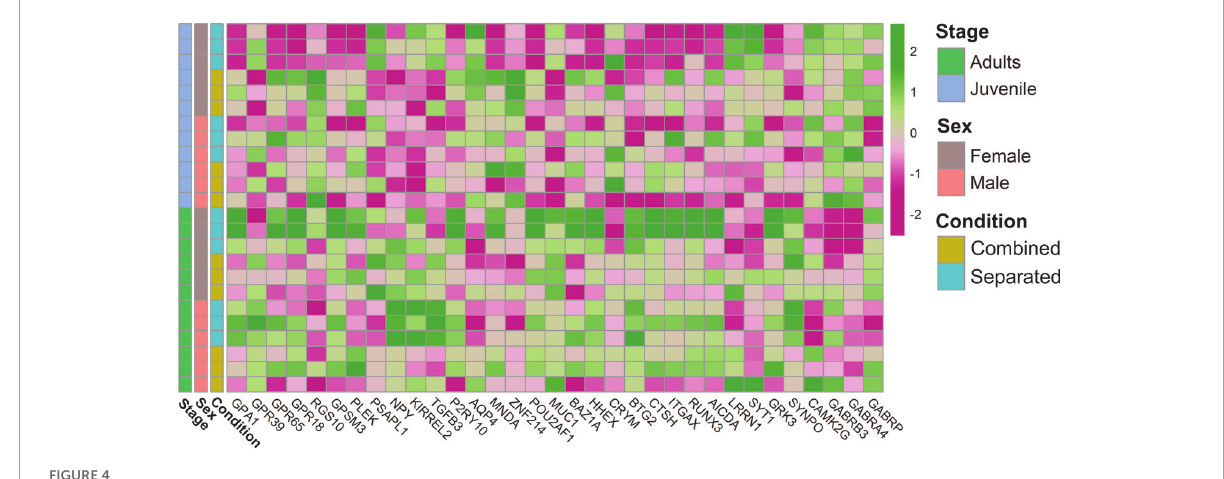
MOE, in which odorant exposure led to reprogramming via the modulation of